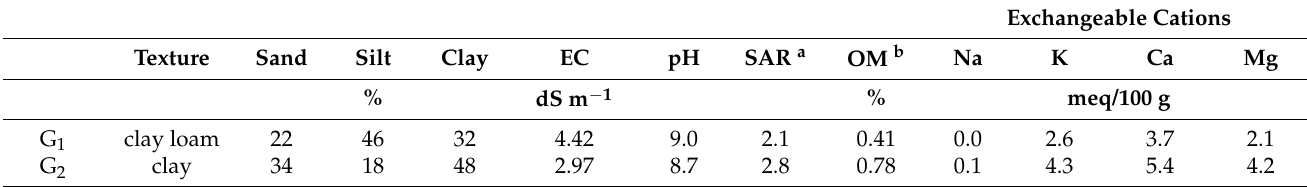
Figure 2. Greenhouse studied. Table 1. Physical and chemical properties of the soil. Electrical conductivity (EC), pH and sodium adsorption ratio (SAR) were determined in the water extract from saturated soil paste. Organic matter (OM) and exchangeable